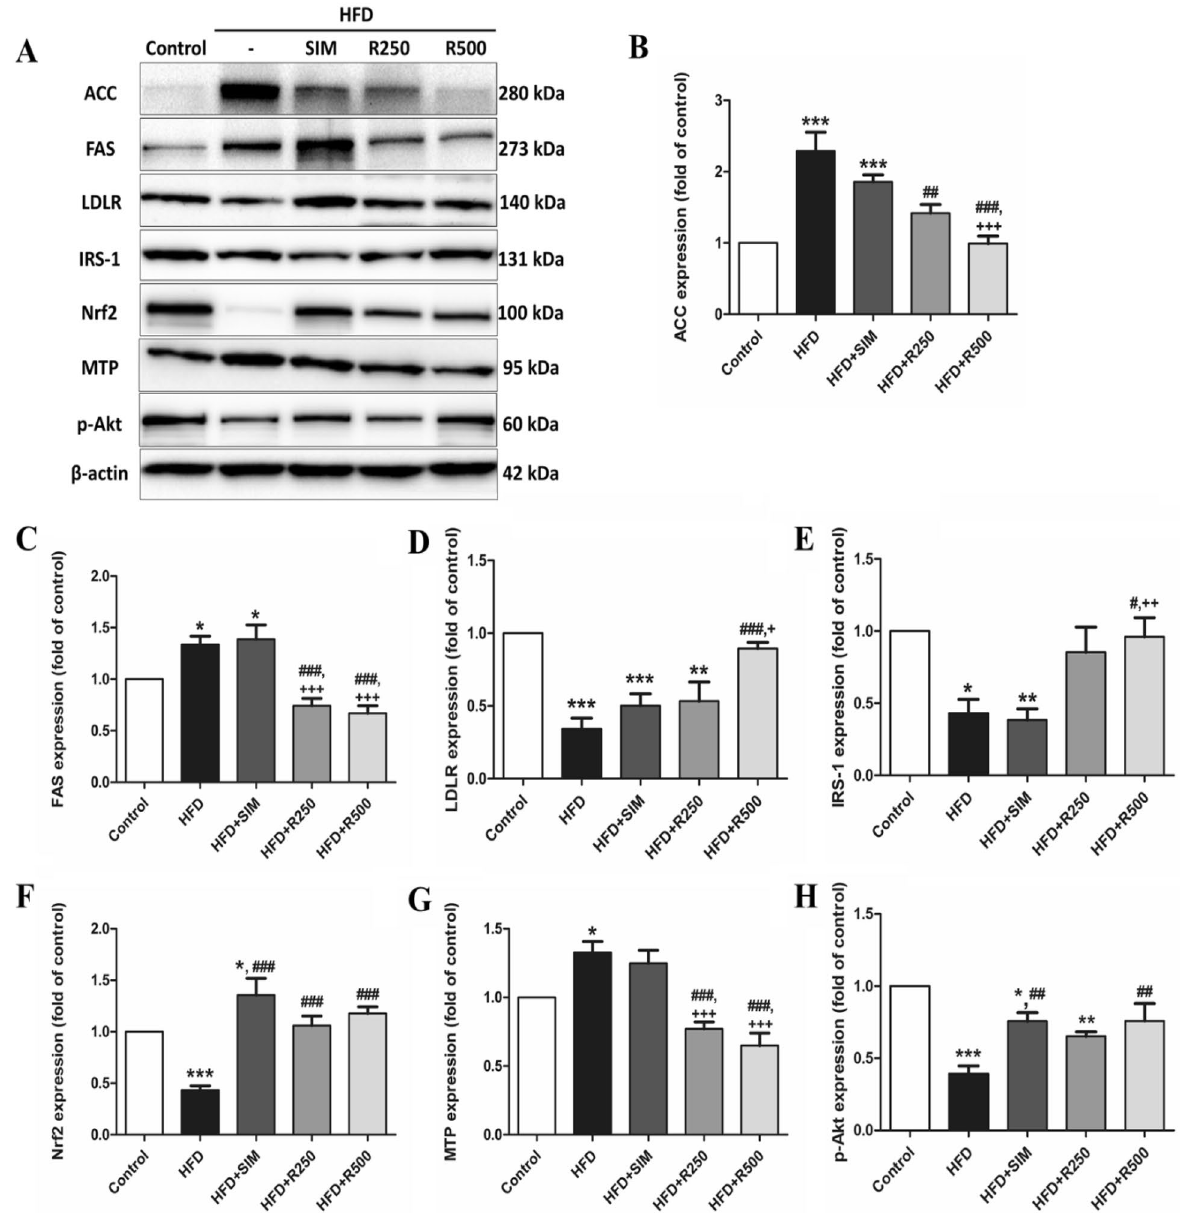
Figure 5. Effect of roselle extract on hepatic protein expression in rats fed high fat diet. ( A ) Band intensity of protein of interest, ( B ) ACC, ( C ) FAS, ( D ) LDLR, ( E ) IRS-1, ( F ) Nrf2, ( G ) MTP, and ( H ) p-Akt (Ser473). The bands are cropped from the original blots which are presented in Supplementary Fig. S3. The data are presented as means ± SD of individual experiments from 5–7 animals per group. The statistical differences as indicated by one-way ANOVA followed by Tukey’s post hoc test. The mean differences were significant compared with the control group (* P < 0.05, ** P < 0.01, *** P < 0.001), HFD group ( # P < 0.05, ## P < 0.01, ### P < 0.001) and HFD + SIM group ( + P < 0.05, ++ P < 0.01, +++ P <